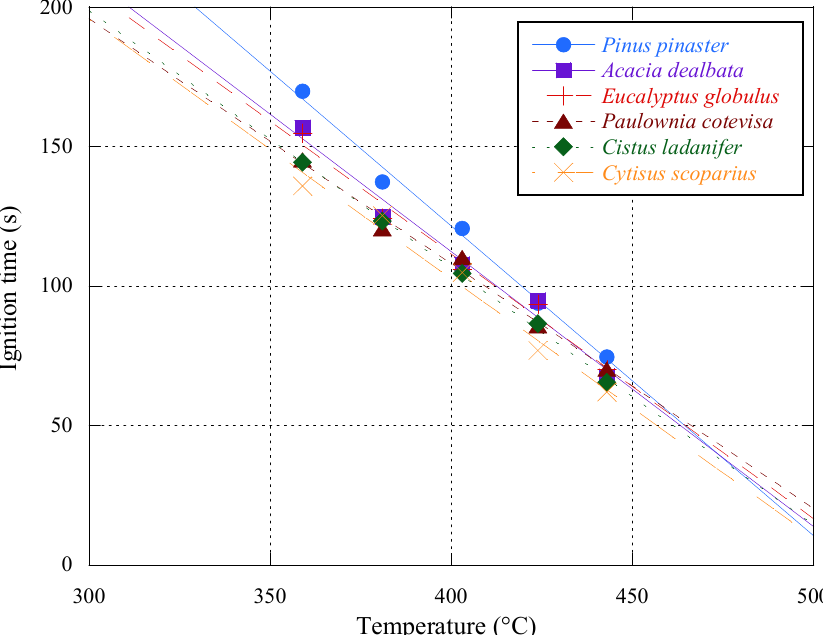
Figure 7. Pellet ignition time as a function of furnace temperature.